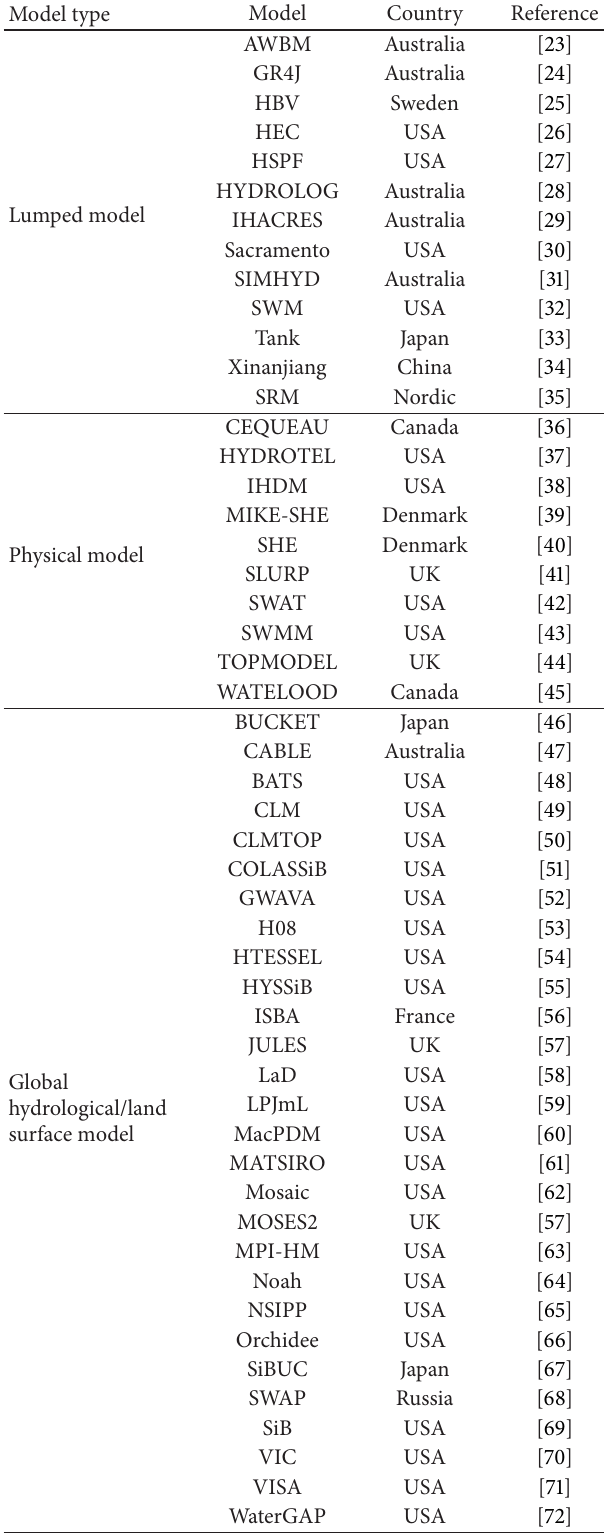
Table 1: Major catchment, regional and global runoff